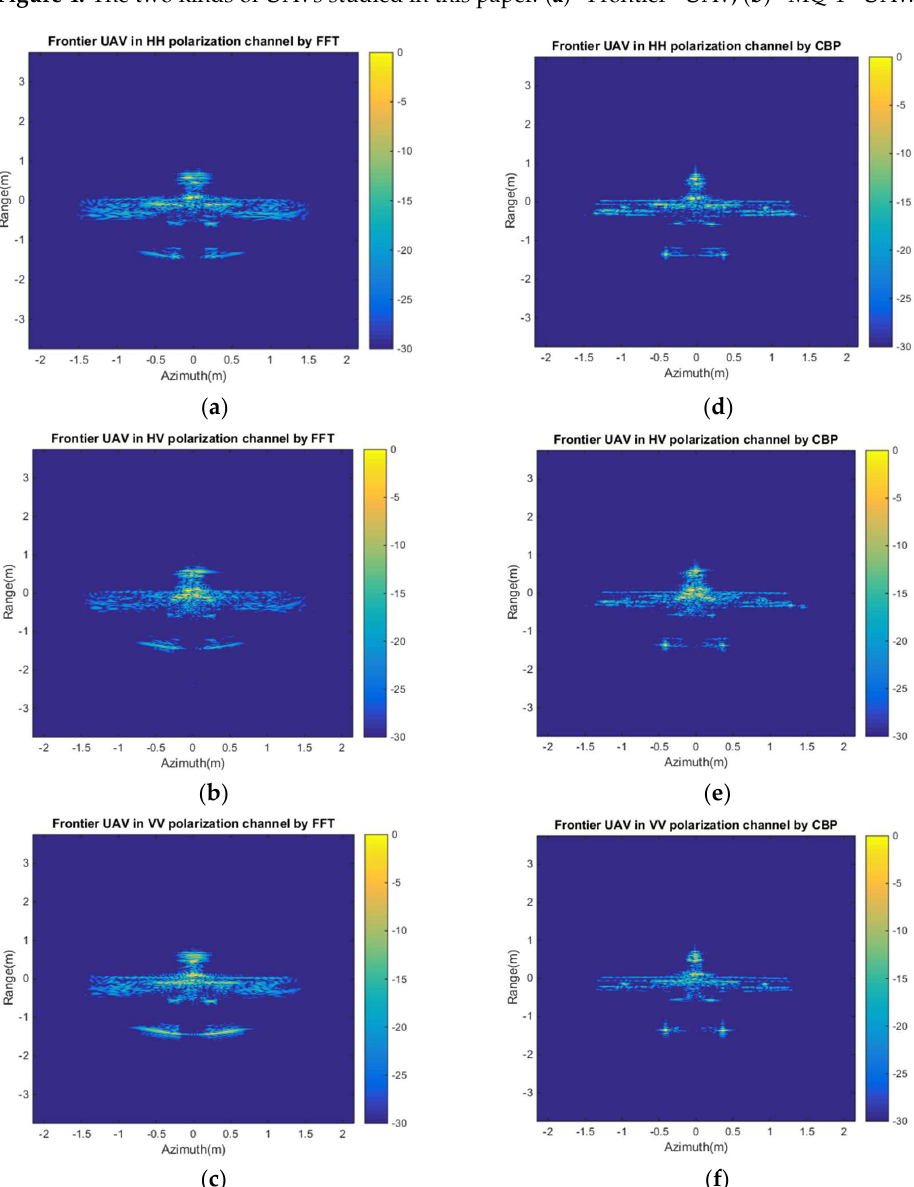
Figure 5. The full-polarization imaging results of the “Frontier” UAV with the FFT and CBP algorithm ( a ) “Frontier” in HH polarization by FFT; ( b ) “Frontier” in HV polarization by FFT; ( c ) “Frontier” in VV polarization by FFT; ( d ) “Frontier” in HH polarization by CBP; ( e ) “Frontier” in HV polarization by CBP; ( f ) “Frontier” in VV polarization by CBP.